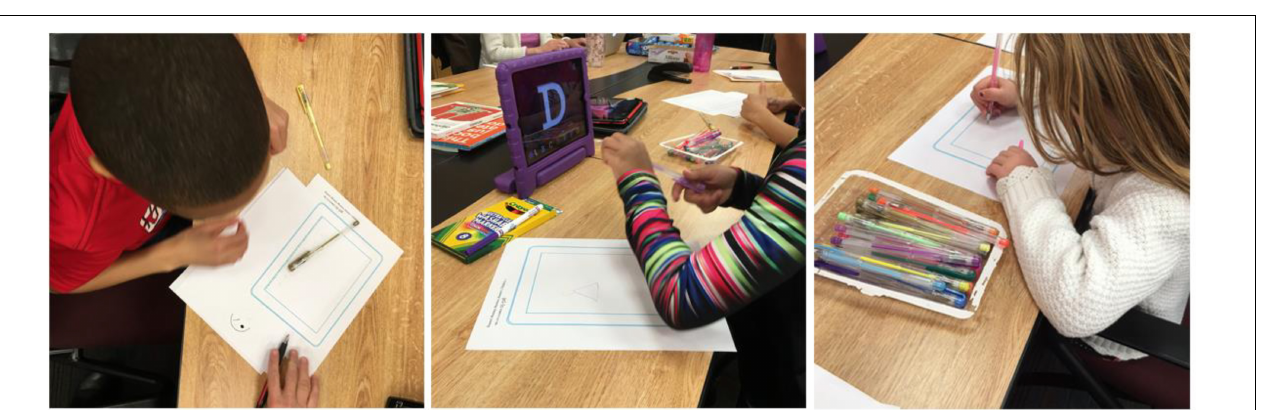
FIGURE 1 | Paper prototype testing with different slab serif and san-serif typefaces.